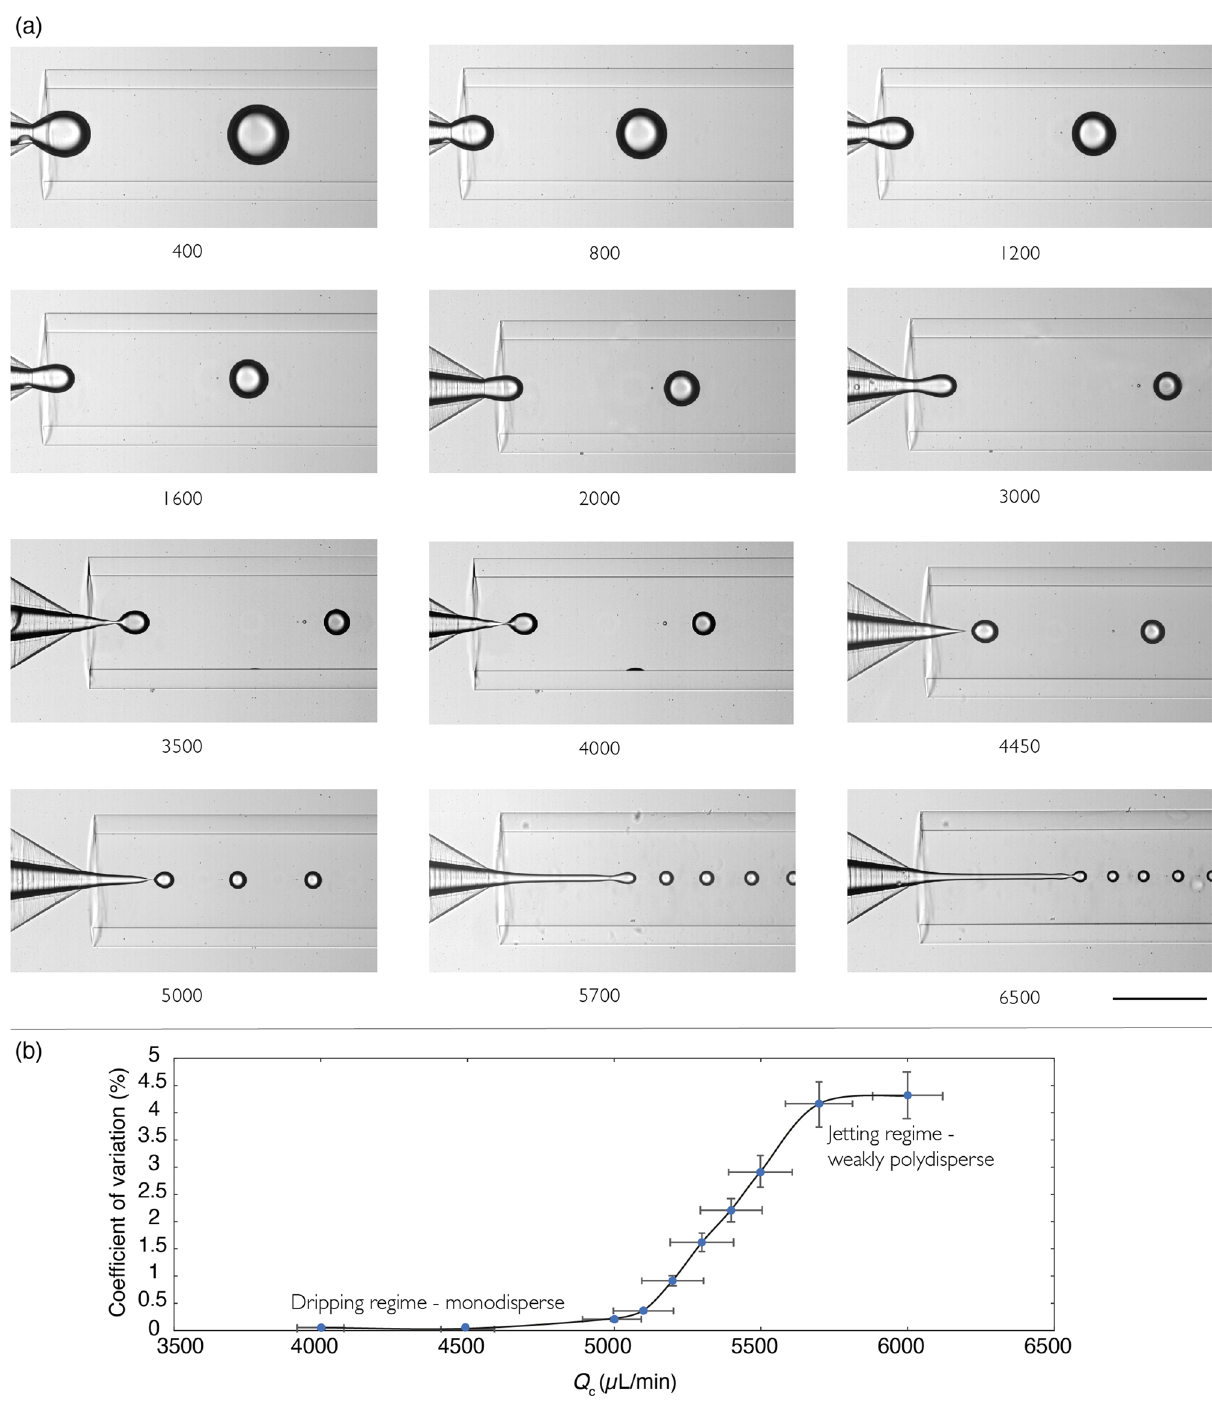
Figure 4. Water droplets in mineral oil using couple 2. ( a ) Q d is fixed at 50 µ L/min while the values of Q c are reported below each image. The scale bar is 450 µ m. Capillary numbers as defined in Eq. (9) and with Ca d = ¯ Q Ca c , are Ca d = 0.0024 and Ca c = 4.9 × 10 − 5 Q c , with Q c in µ L/min. ( b ) Coefficient of variation (CV) versus Q c for Q d fixed at 50 µ L/min. The transition between the dripping monodisperse regime and the weakly polydisperse jetting regime occurs for Q c ≈ 5200 ± 500 µ